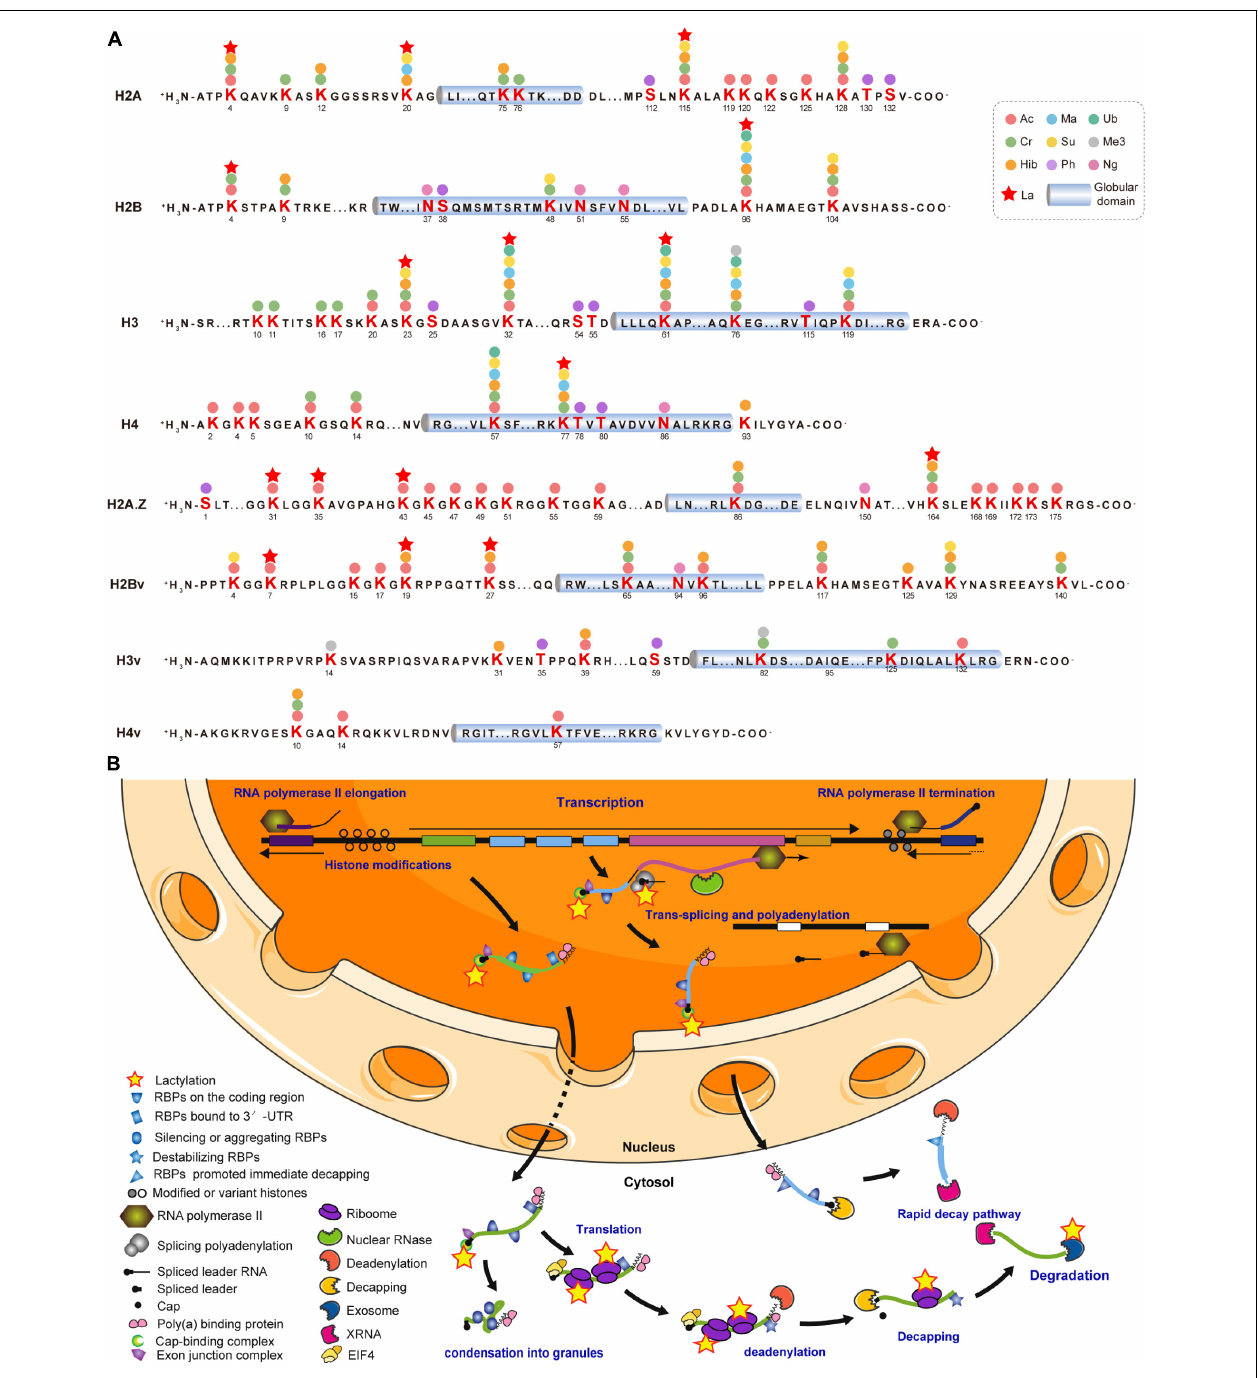
FIGURE 3 | Lysine lactylation occurs on histones and gene regulators. (A) Cylinders indicate globular histone domains. Mature histone sequence is shown with modified residues in bold. Numbers represent amino acid positions after initial Met was removed. (B) This diagram is modified from Clayton (2016, 2019). Multiple ORFs lacking introns are arranged in a head-to-tail manner with some tandem repeats and occasional directional changes (Clayton, 2016). Most RNA Pol II transcription is initiated in DNA stretches several kilobases in length, separating gene arrays orientated in opposite, diverging directions. Initiation and termination regions are enriched with modified and variant histones. Pre-mRNA is processed into mature mRNAs by trans -splicing capped spliced leader and polyadenylation. Completed mRNA is exported to cytosol with bound poly (A) binding protein (PABP; Zoltner et al., 2018), exon junction complex (EJC; Bercovich et al., 2009), and nuclear cap-binding complex (CBC; Freire et al., 2017). Certain untranslated mRNAs bind and silence or induce the aggregation of RBPs, followed by condensation into granules. Mature mRNA binding by EIF4 is followed by translation (Dhalia et al., 2006). Stabilizing RBP is replaced by destabilizing RBP, followed by deadenylation (Schwede et al., 2009). After decapping, mRNA is degraded by XRNA and exosome (Fadda et al., 2013). A subset of mRNAs is immediately degraded. Kla proteins are represented by yellow pentagrams. RBPs are unlabeled but listed in Supplementary Table 5 .